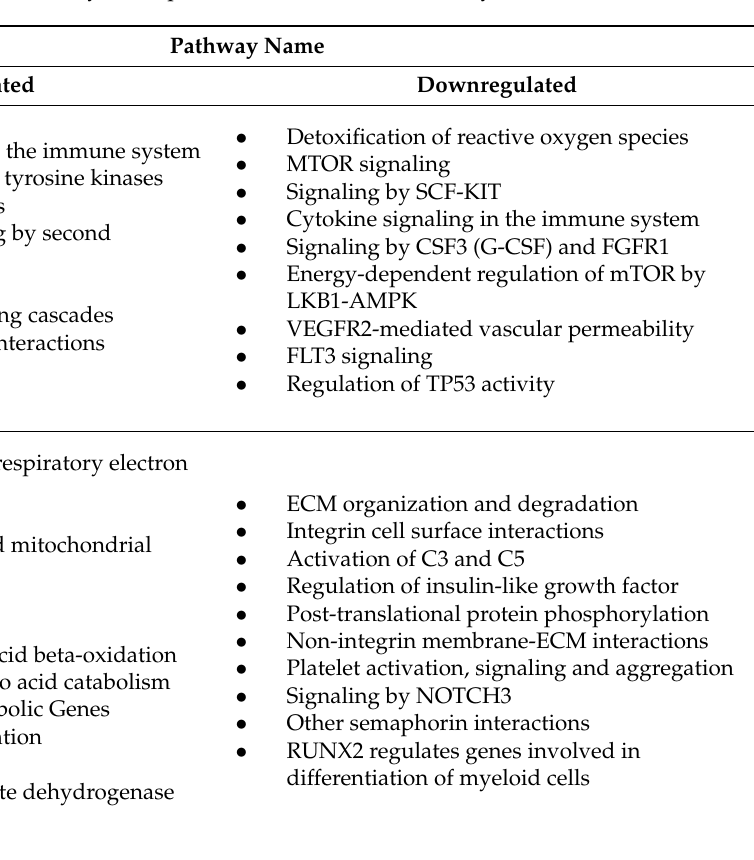
Table 3. Pathways modified by cardioprotective interventions after myocardial